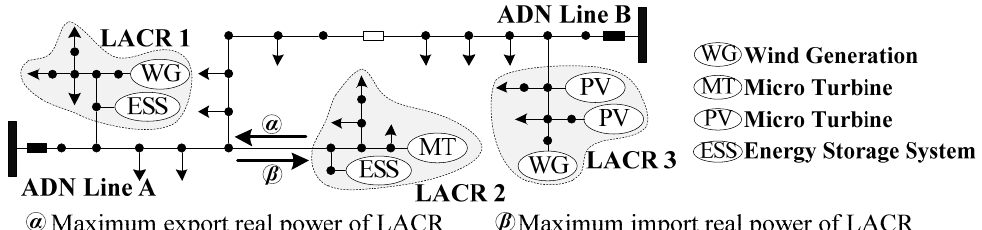
Figure 1. ADN line and local autonomy control